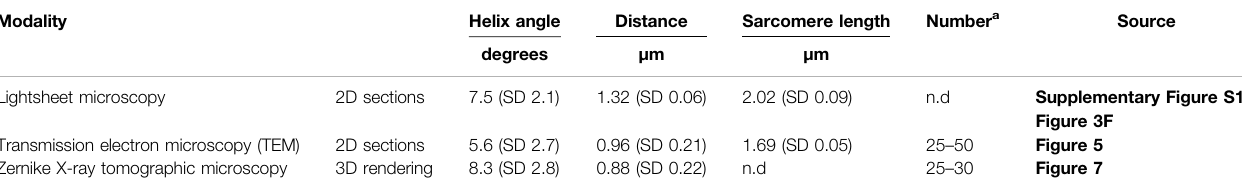
TABLE 1 | Myo fi bril